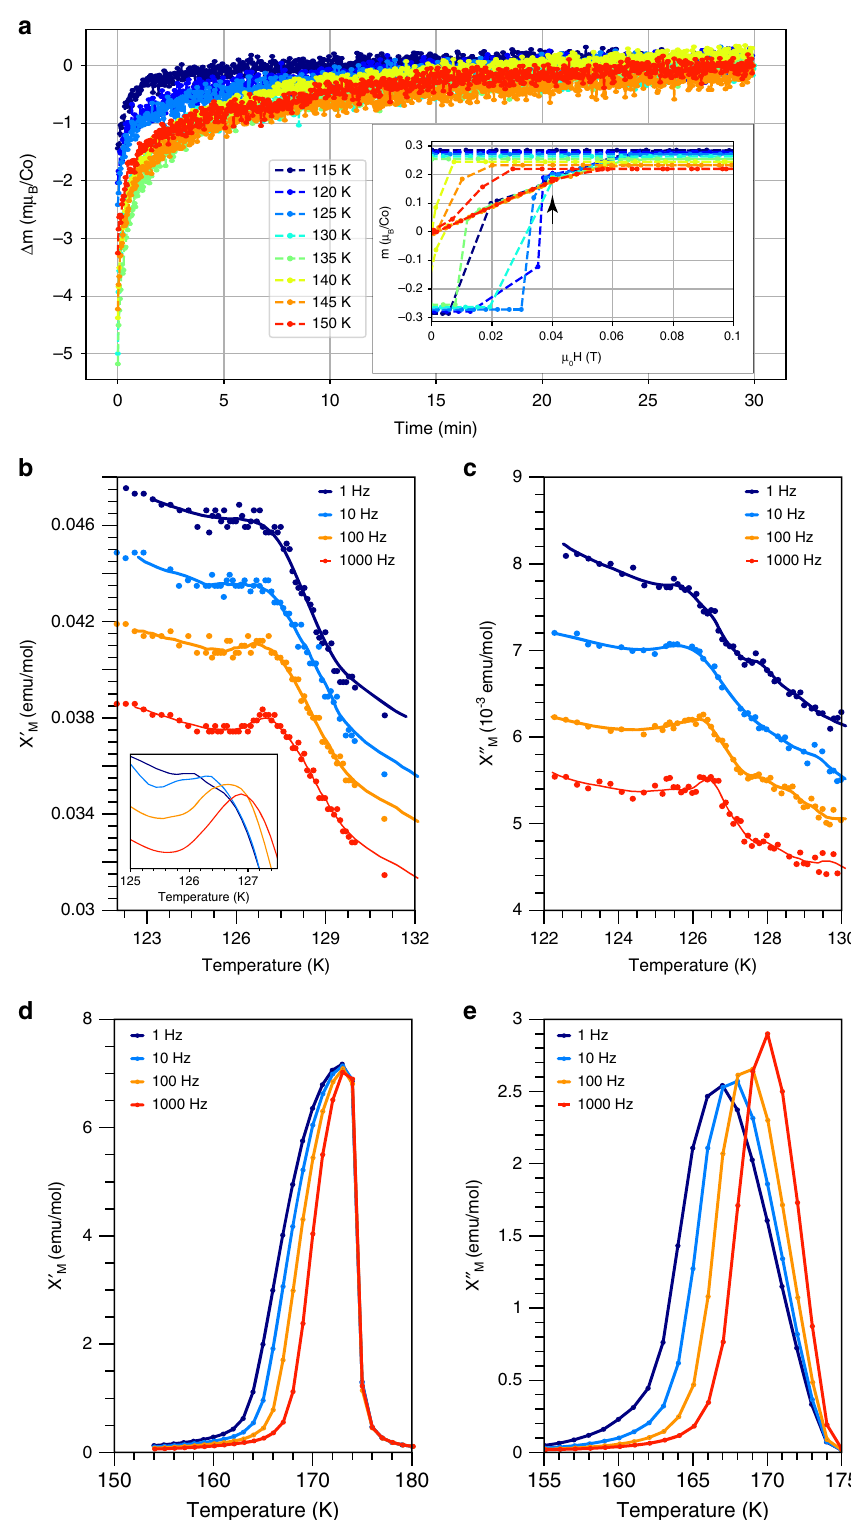
Fig. 6 Non-trivial dynamics of magnetization and AC susceptibility measurements around T G . a Magnetic relaxation at different temperatures reveals a relaxation time on the order of minutes. The inset shows the point on the hysteresis loop where the fi eld ramp was paused ( μ relaxation measurement was taken (marked with an arrow). After a period of 30 min, the fi eld sweep was resumed, saturating the magnetization to the maximum value for the speci fi c temperature. b – e AC susceptibility measurements acquired with zero applied DC fi eld and an oscillating fi eld of 6.2 Oe, showing real and imaginary components of the signal at T G ( b , c ) and T c ( d , e ). Peak shifts by ~0.2 K per decade frequency at T G and 1 K at T c . Smoothed curves are guides for the eye. T G curves have been vertically offset for clarity. Inset of b shows smoothed curves overlaid as a visual aid for the observed frequency